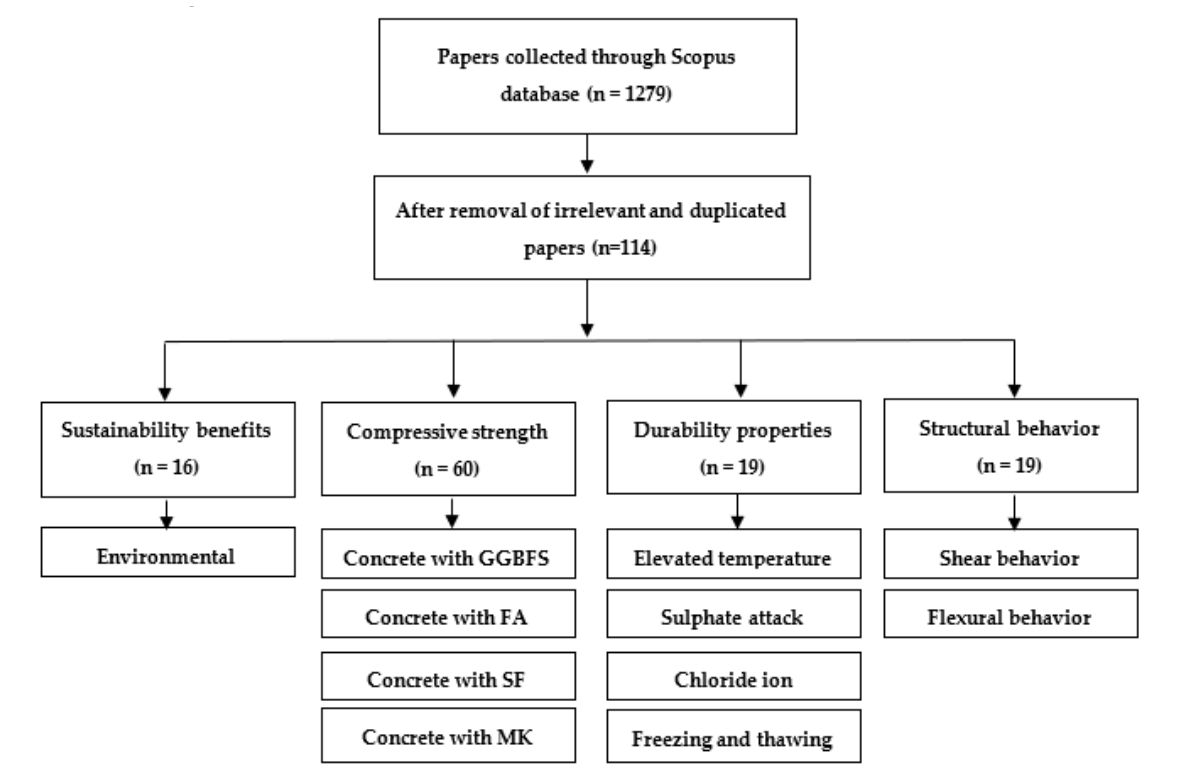
Figure 1. The process used to conduct this review.